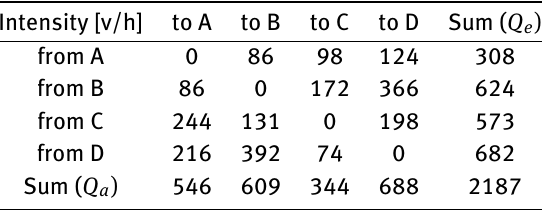
Table 1: Intensities found out by the traflc survey. Source: